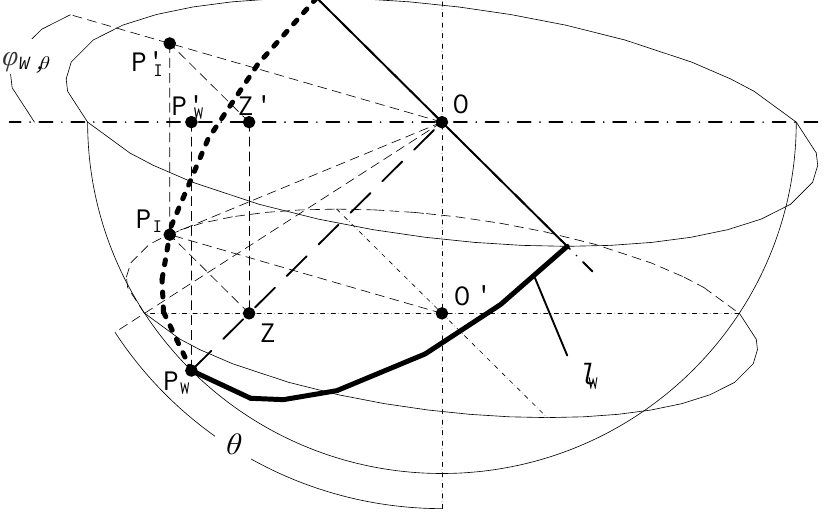
Figure A2. Ω W geometric sketch.